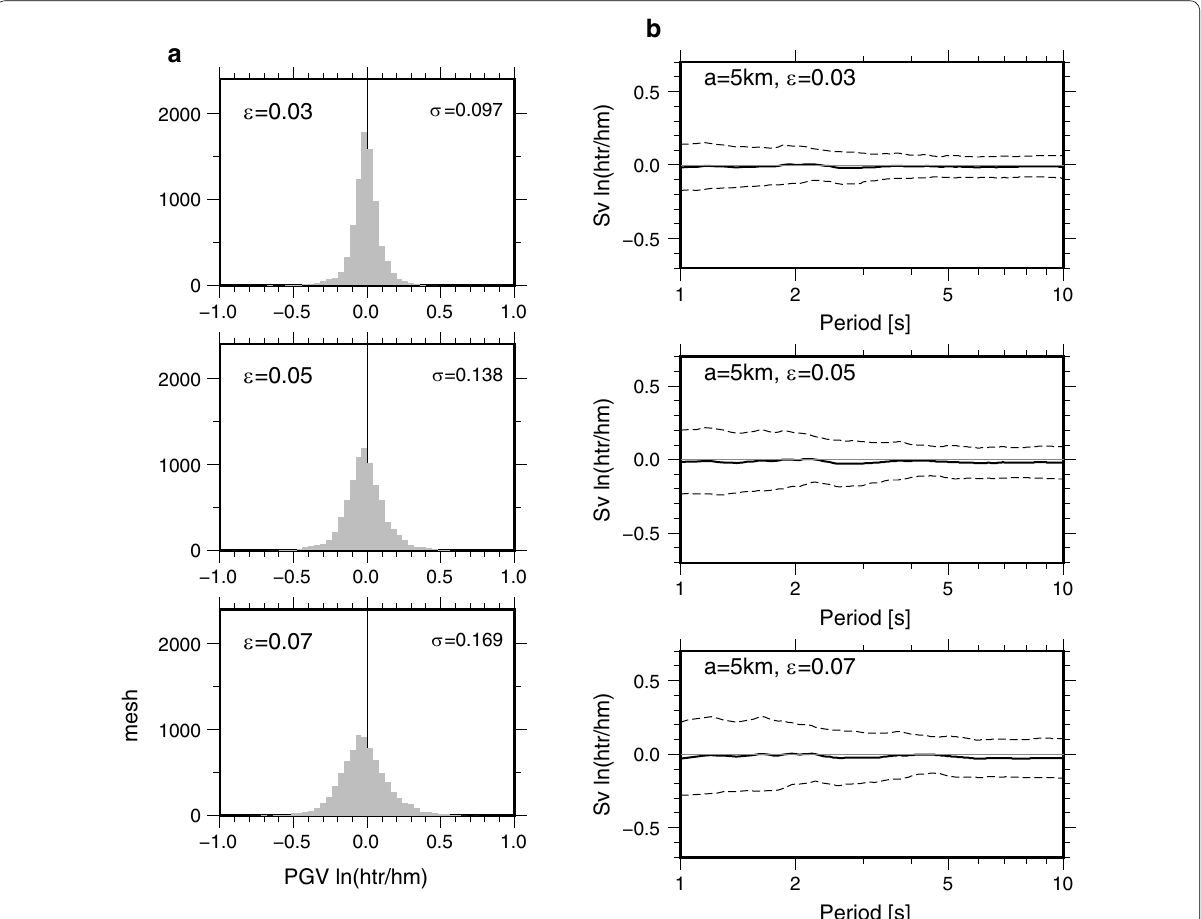
Fig. 11 Effect of the heterogeneity with different values of standard deviation ( ε 0.03, 0.05, and 0.07). Simulation results for the correlation length = of 5 km and the S1_3.3 source model are used. a Distribution of natural logarithm of heterogeneous-to-homogeneous PGV ratio (see Fig. 7 caption for detail). b Model bias of the heterogeneous model from the homogeneous model for response spectra with mean (solid lines) and standard deviation (dashed lines). See Fig. 10 caption for detail; note that it is for one random